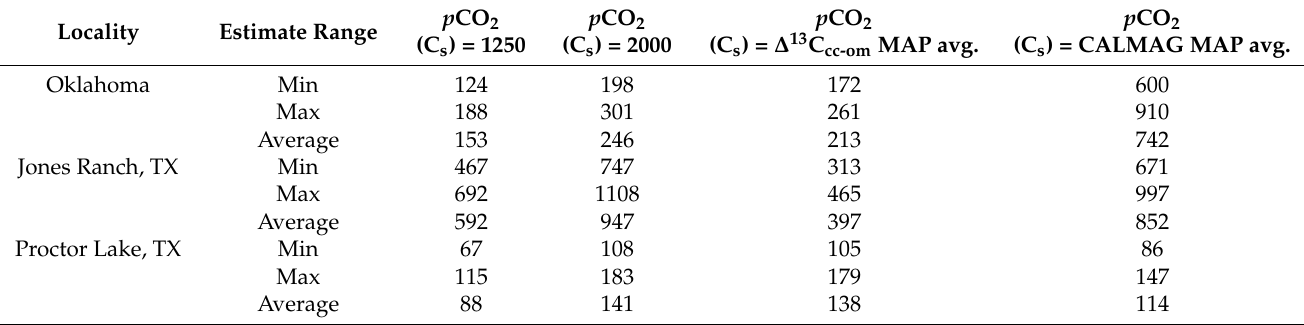
Table 3. The estimated atmospheric p CO 2 estimates calculated with the C s values of 1250 and 2000ppmV. The estimated atmospheric p CO 2 values calculated using C s values based on average mean annual precipitation estimates using the ∆ 13 C cc-om proxy [42] and CALAMG weathering index [41] are shown in the last two columns. The values show the minimum, maximum, and average p CO 2 calculated for each